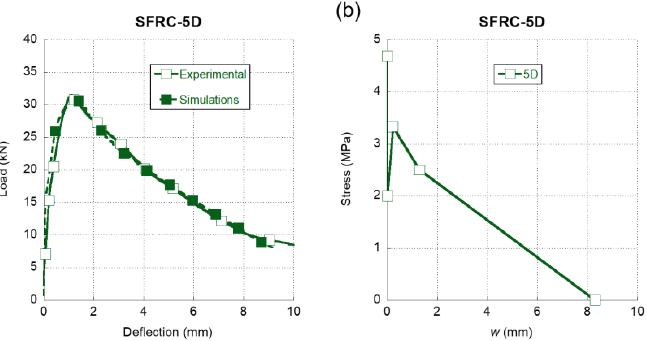
Figure 6. ( a ) Comparison of the average experimental results obtained in the fracture tests of SFRC-5D and the numerical simulation. ( b ) Softening function used in the simulation shown in ( a ).